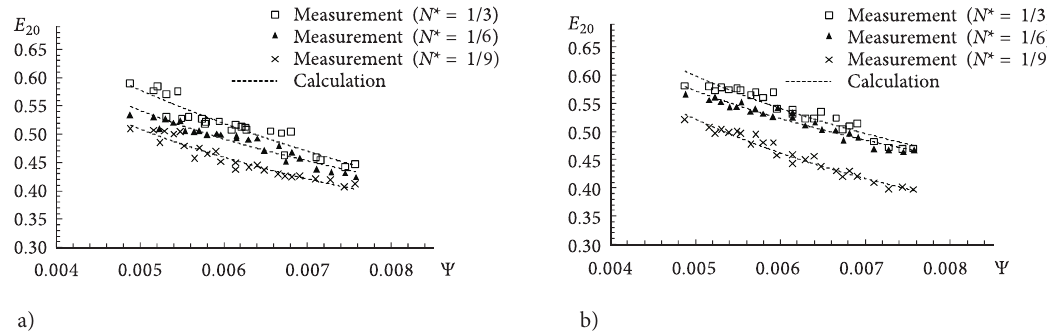
Fig. 10. Relationships between E and Ψ for: (a) parallel flashboard spillways; (b) interlaced flashboard spillways 20